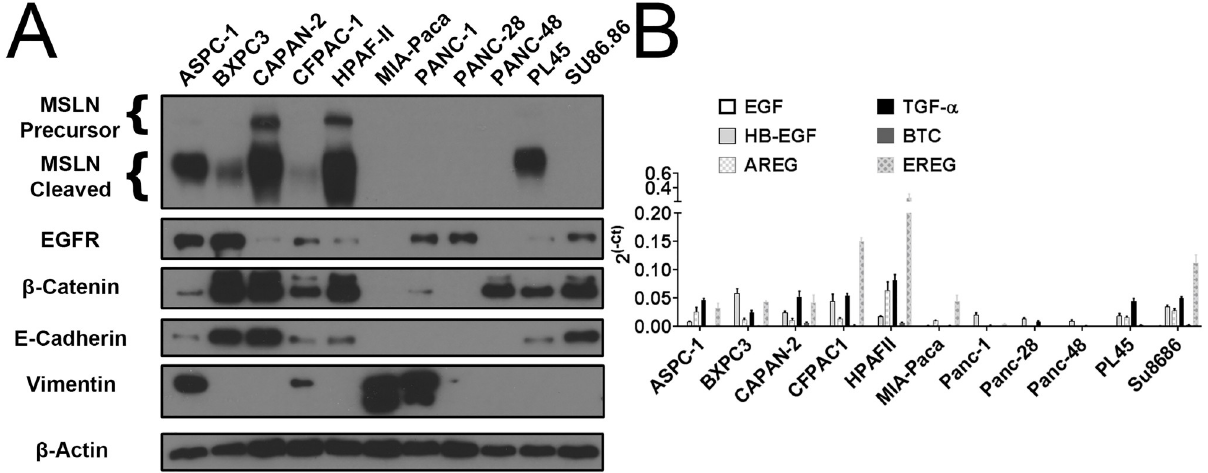
Fig 2. Expression levels of important cellular markers associated with EGFR sensitivity. (A) Protein expression levels of mesothelin (MSLN), EGFR, β -Catenin, E-cadherin, and vimentin in 11 PDAC cell lines detected by western blot; (B) RNA expression levels of the EGFR ligands including EGF, Heparin-binding EGF (HB-EGF), Amphiregulin (AREG), Transforming Growth Factor α (TGF- α ), Betacellulin (BTC), and Epiregulin (EREG) detected by RT-PCR. Y-axis represents relative mRNA levels to GAPDH control.